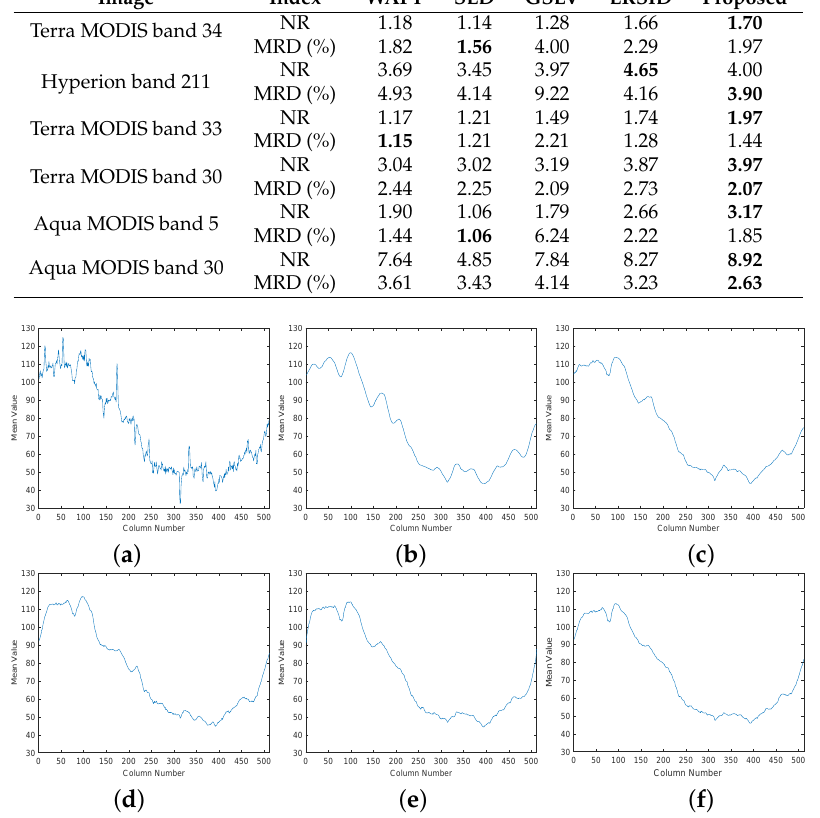
Table 4. Quantitative indices NR and MRD results of the test methods for real experiments.